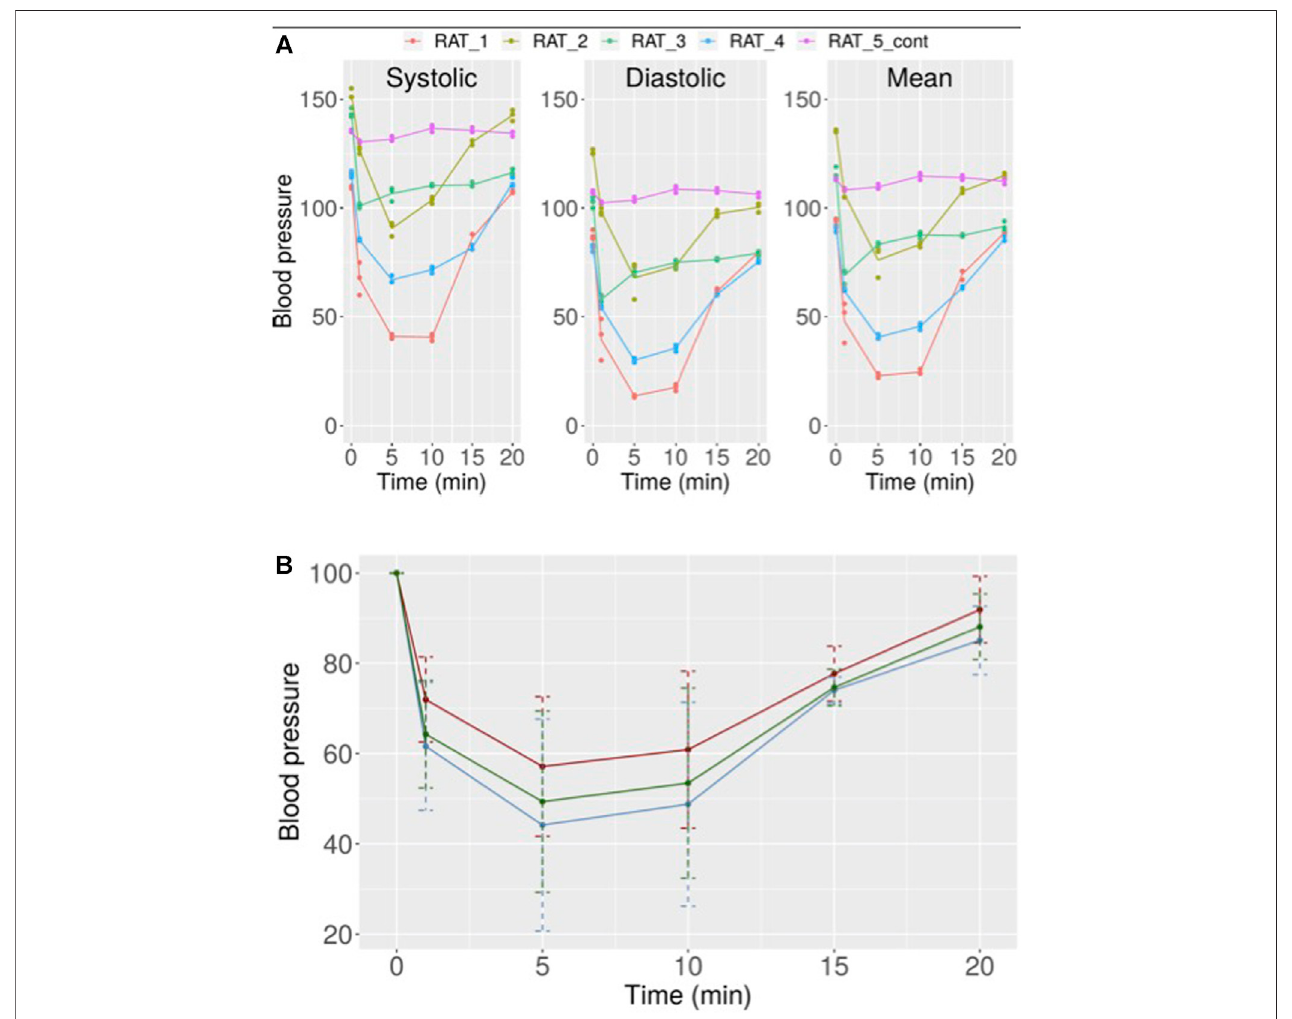
FIGURE9|(A) Variationinsystolic,diastolic,andmeanbloodpressureinratsaftertreatmentwith10 µMCC.Independentresultsobtainedfor fi veratsareshown. (B) Mean values with error for the results obtained for all rats after treatment with 10 µM CC (red: systolic pressure, blue: diastolic pressure, green: mean pressure).